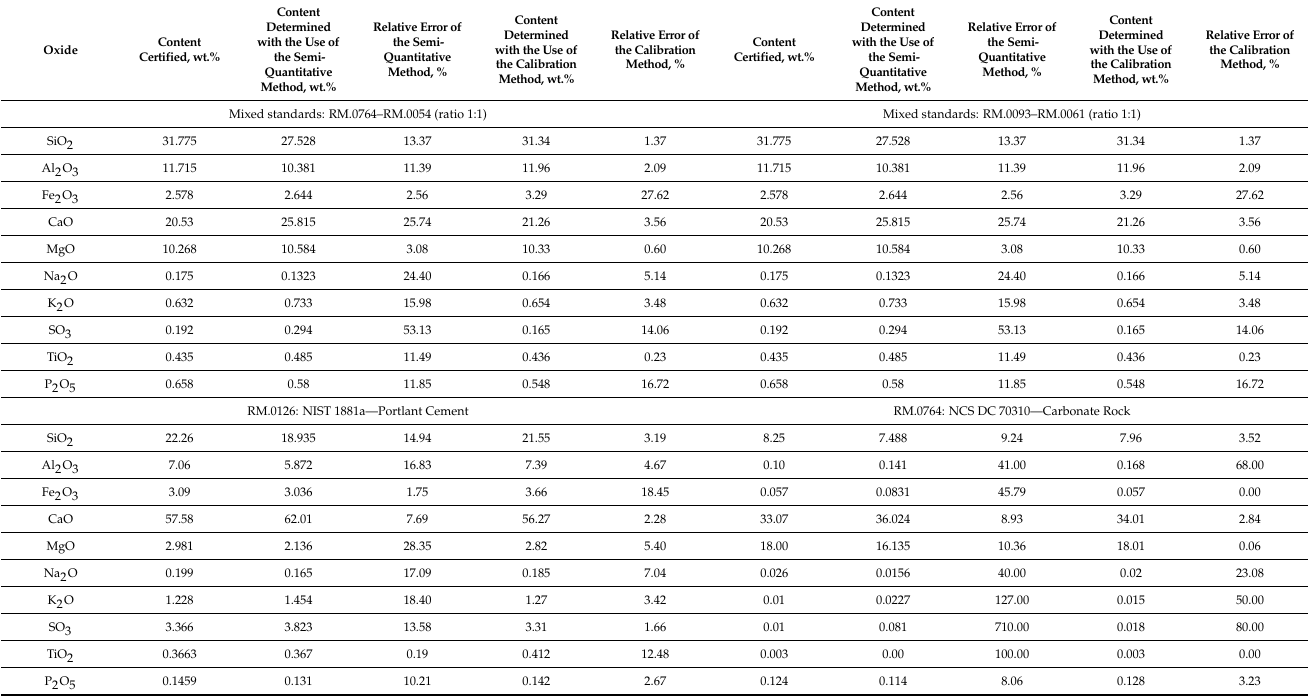
Table 9. Results accuracy estimation for the semi-quantitative analysis of the Rigaku ZSX Primus II wavelength dispersive X-ray fluorescence